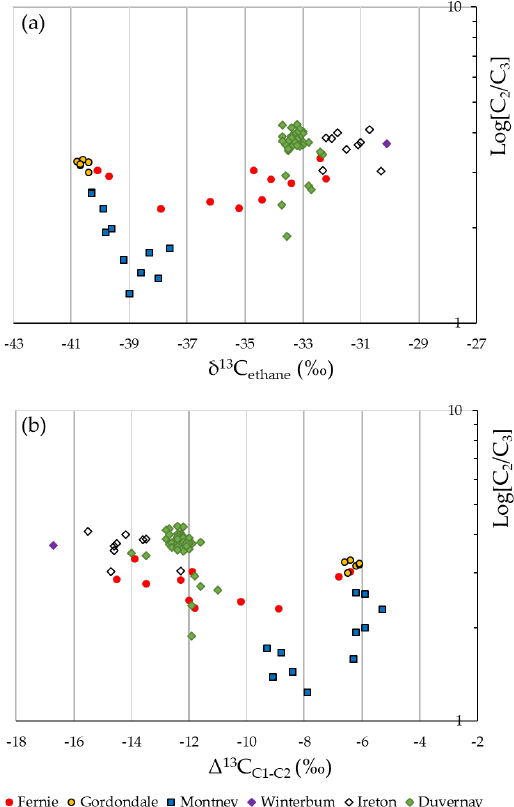
Figure 4. The relationship between the C 2 /C 3 ratio and ( a ) the δ 13 C of ethane, and ( b ) the Δ 13 C C1-C2 difference; for samples from the KAYBOB 4-16-64-20 well, western Alberta.